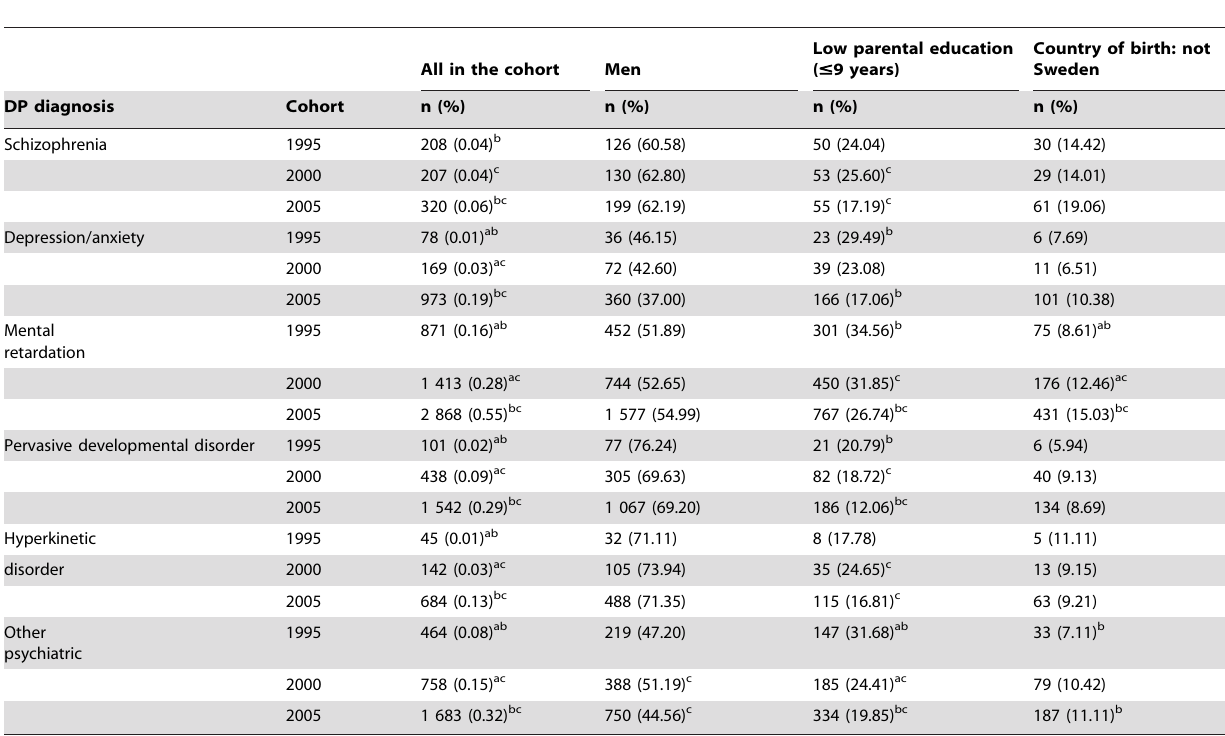
Table 2. Demographic data for young adults 19–23 years old with disability pension (DP) due to specific psychiatric diagnoses in the three studied cohorts of 1995, 2000, and 2005,